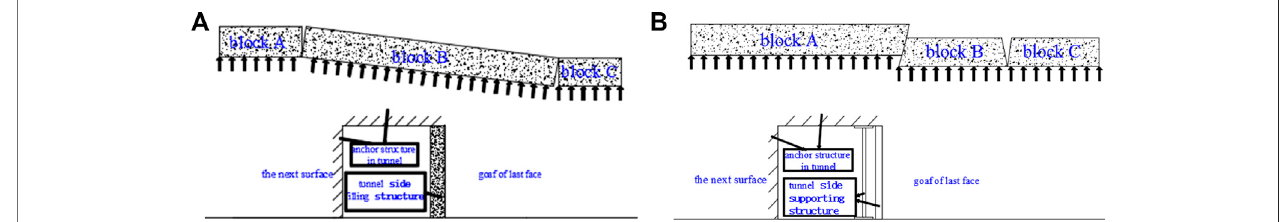
FIGURE 2 | Schematic diagram of basic roof fracture. (A) Filling retaining roadway, (B) no fi lling entry.